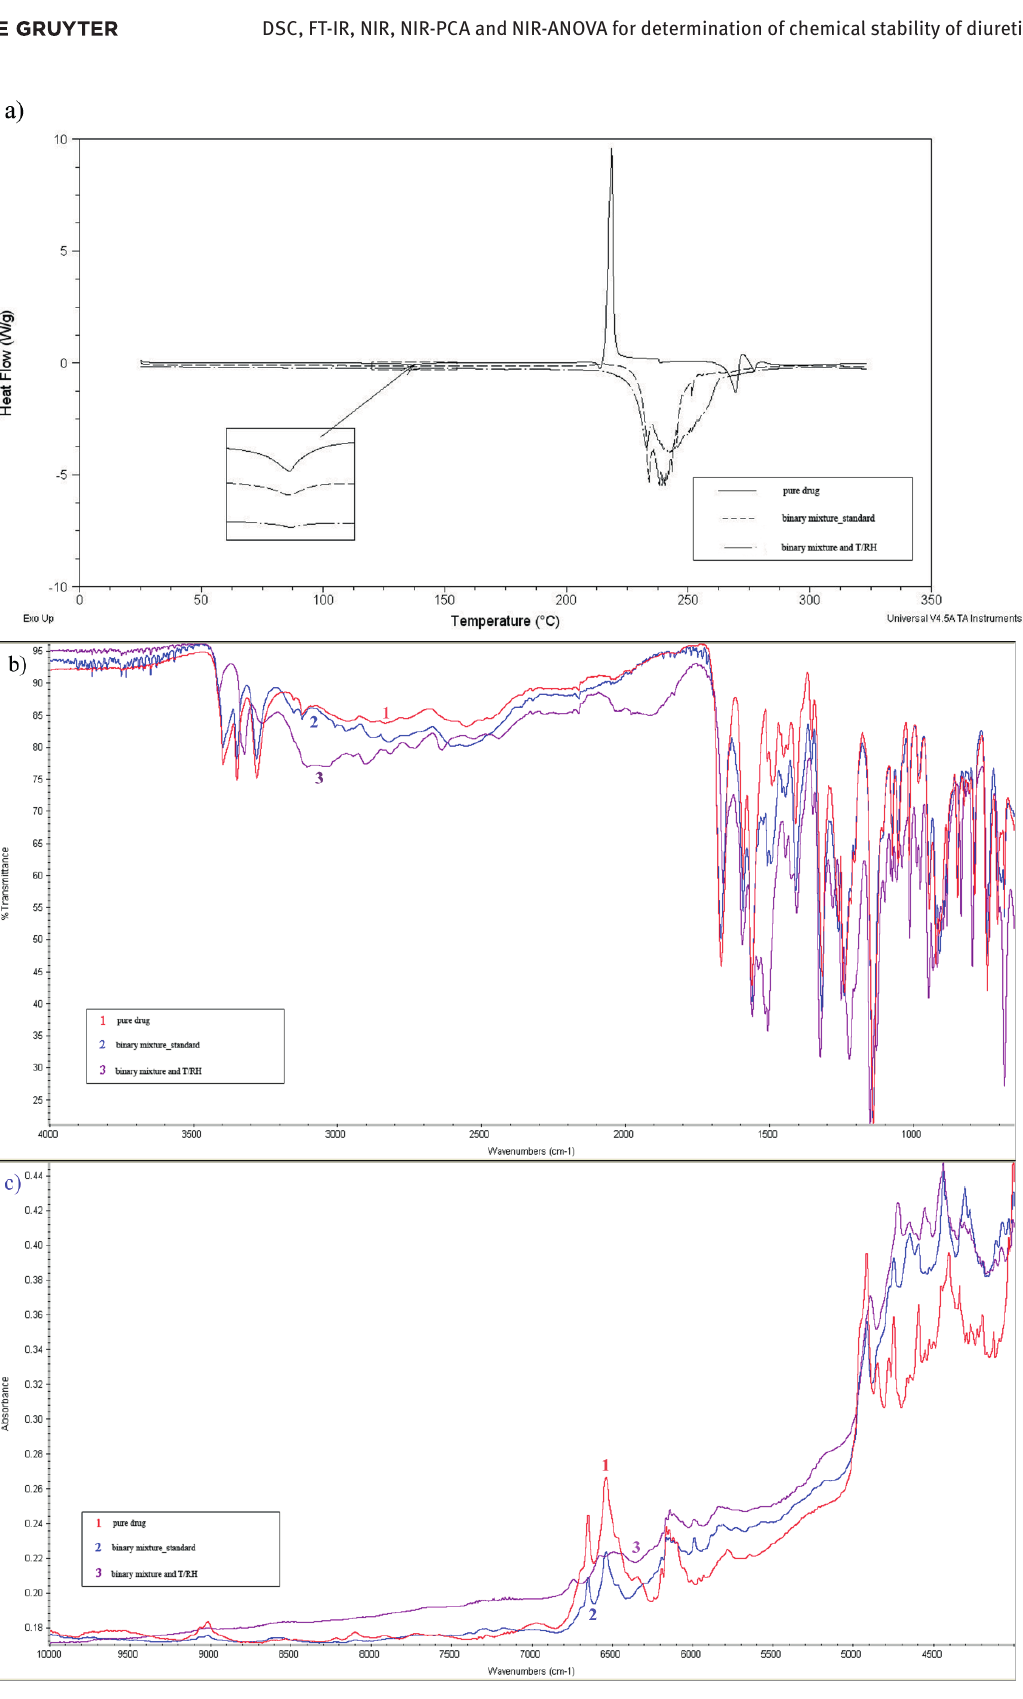
Figure 4 : Furosemide and glycine: DSC scans (a), FT-IR spectra (b) and NIR spectra (c) for the mixture stressed with high temperature/ humidity (T/RH) and the untreated mixture (standard) against pure